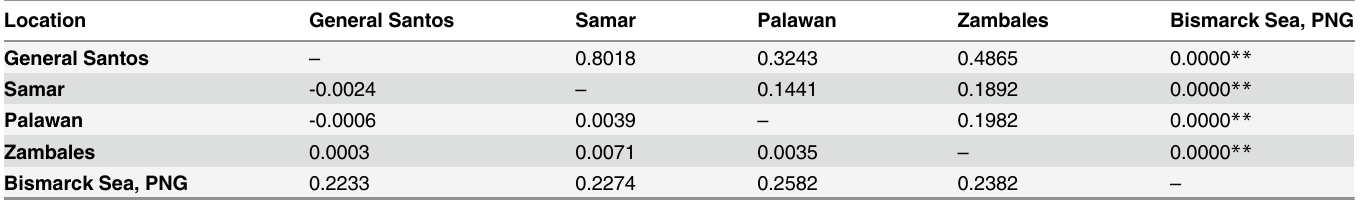
Distance method based on number of different alleles of nine microsatellite